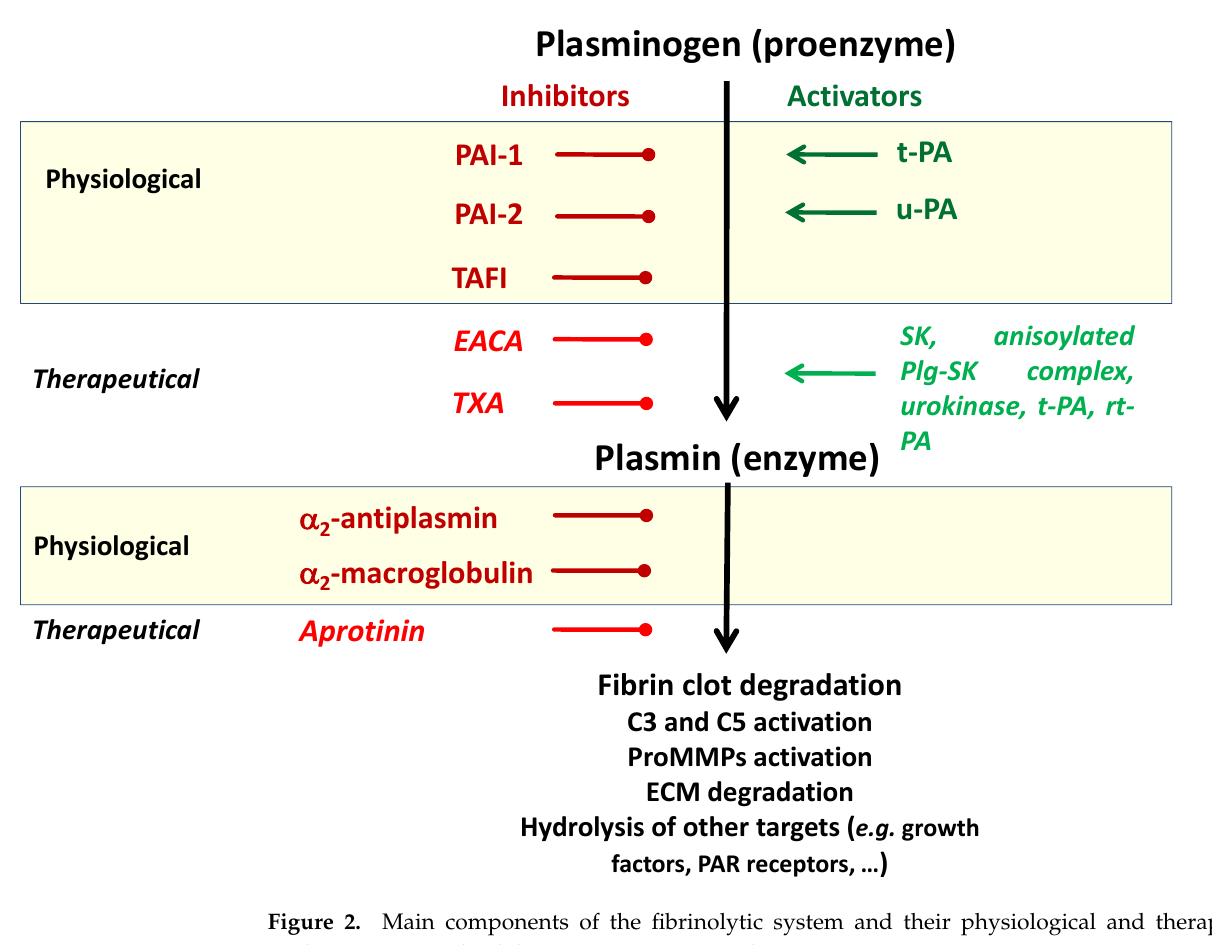
Figure 2. Main components of the fibrinolytic system and their physiological and therapeutical ac- tivators and inhibitors. C3, C5 - complement components; EACA- aminocaproic acid; ECM - extra- cellular matrix; PAI-1, PAI-2 - plasminogen activator inhibitors 1 and 2; PAR - protease-activated receptor; Plg-SK - plasminogen-streptokinase; proMMPs - matrix metalloproteinase zymogenes; rt- PA - recombinant t-PA; SK - streptokinase; TAFI - thrombin-activatable fibrinolysis inhibitor; t-PA-